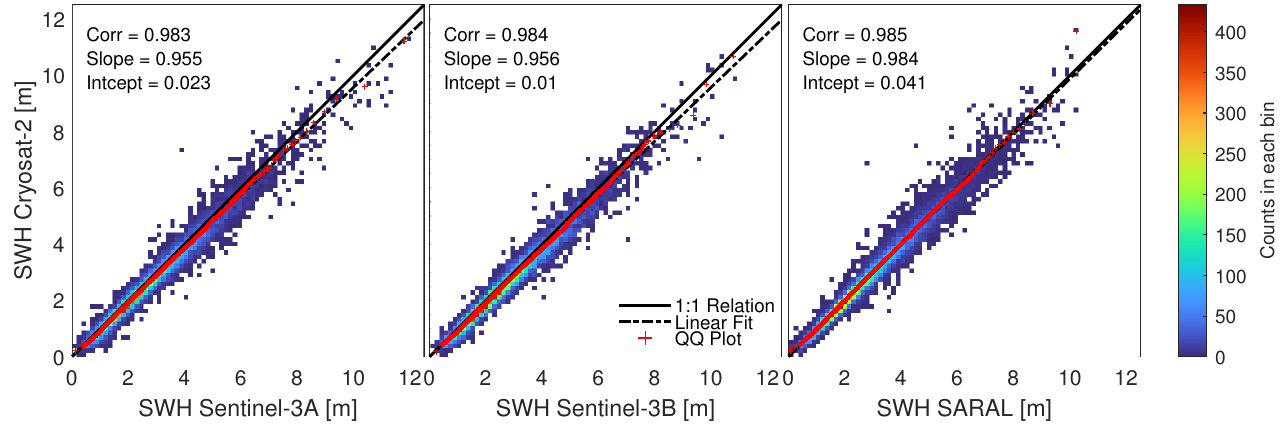
Figure 3. Crossover analysis for three altimeters and CryoSat-2 showing the agreement between SWH observations for crossovers with a time difference of between 2 and 3 h. The correlations are also shown in Table 1; we expect correlations in this